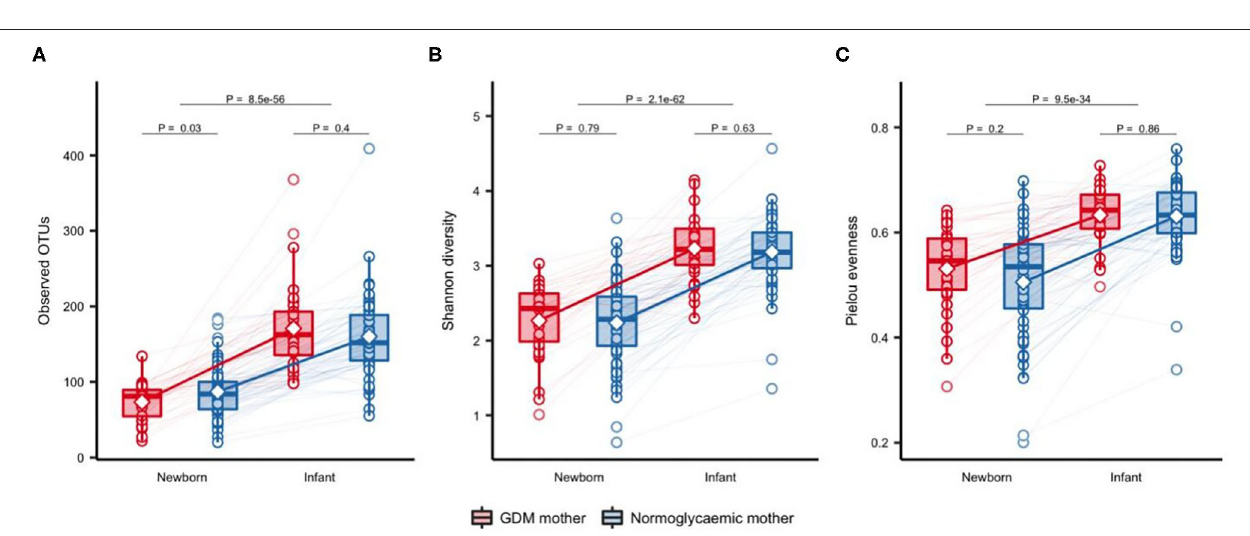
1.9%; P = 0.004) and membership ( R 2 = 1.2%; P = 0.014) from birth to infancy according to GDM status ( Figures 3B,D ) and the difference in community membership remained in infancy (unweighted UniFrac; R 2 = 1.3%; P = 0.03), while community structure remained similar (unweighted UniFrac; R 2 = 1.1%; P = 0.20). Adjustment for pre-pregnancy BMI had a minor attenuating effect on the differential change in